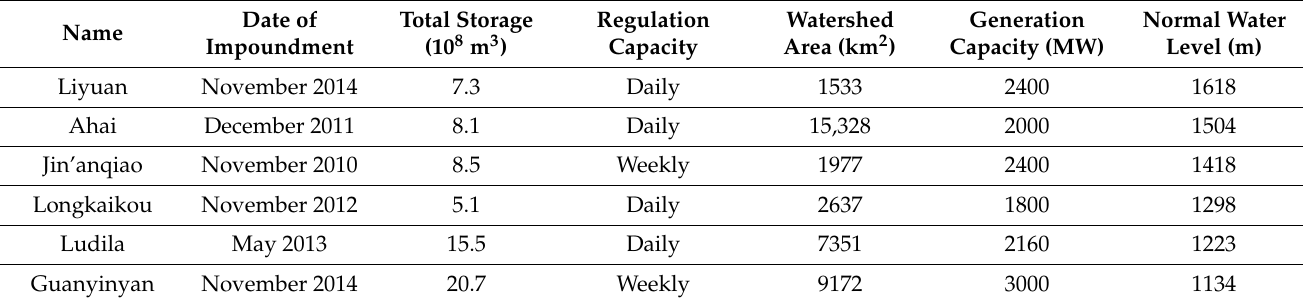
Table 1. Constructed hydropower stations on the main course of the middle reach of the Jinsha River.